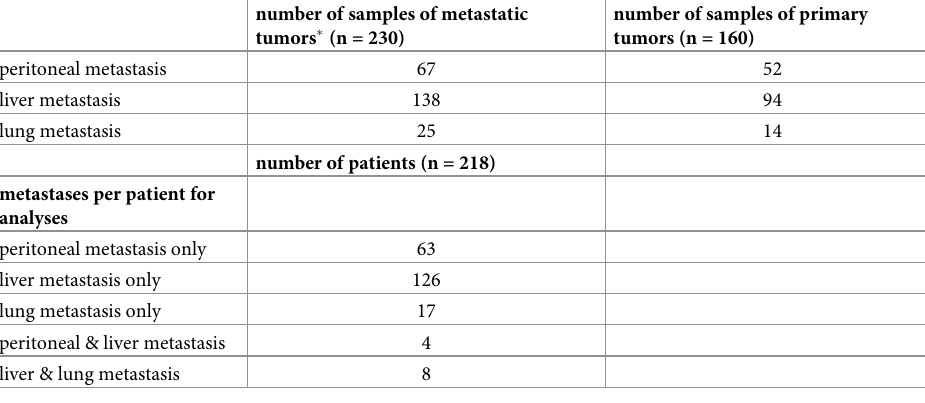
Table 1. Number of primary tumors and metastases used for the analysis. number of samples of metastatic tumors � (n =